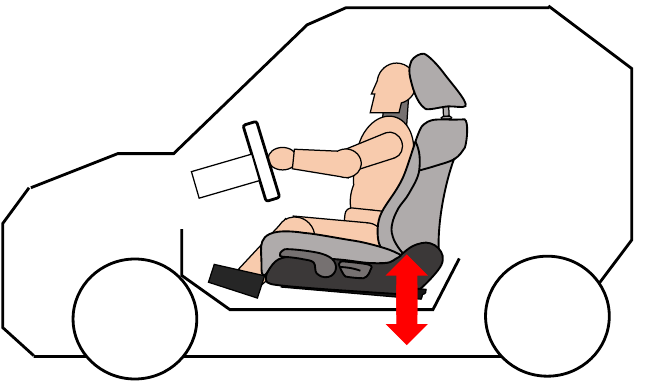
Figure A2. Vibration in automotive seats.